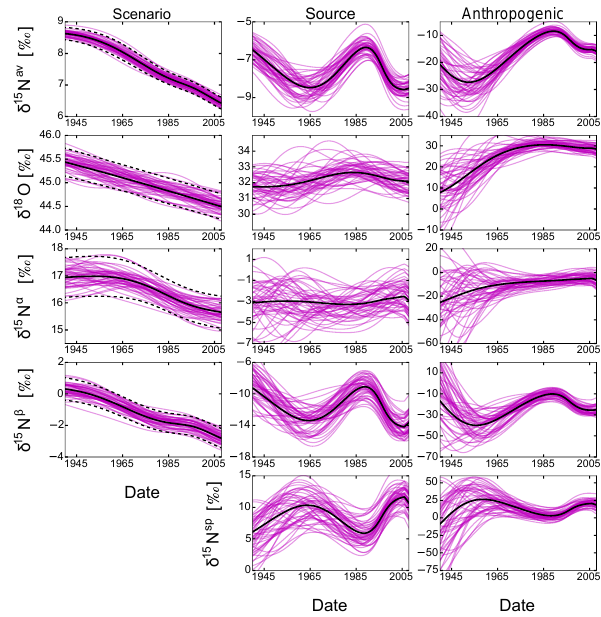
Figure 4. Left panels: historic evolution of δ 15 N av , δ 18 O, δ 15 N α , δ 15 N β , and δ 15 N sp in N 2 O as derived from the firn air recon- struction. Middle panels: isotope signatures of the total emitted N 2 O. Right panels: isotope signatures of the anthropogenic source, respectively. The solid black line represents the best-fit scenario, while the dashed ones represent the respective uncertainties as de- termined by the reconstruction method. Magenta lines represent the emissions that are required to produce the magenta N 2 O histories in the left